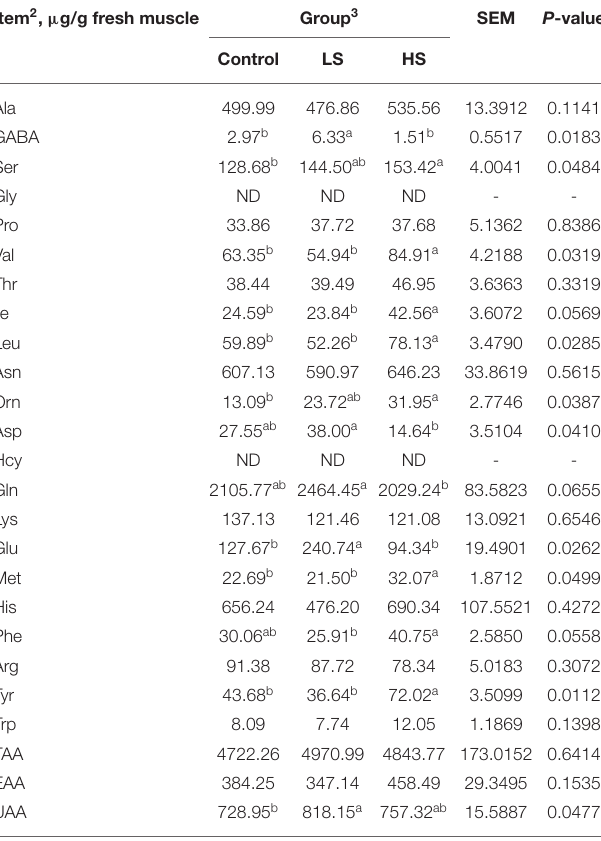
TABLE 6 | Effect of selenium-yeast on longissimus dorsi fatty acid of goats 1 . Items 2 , µ g/g fresh muscle